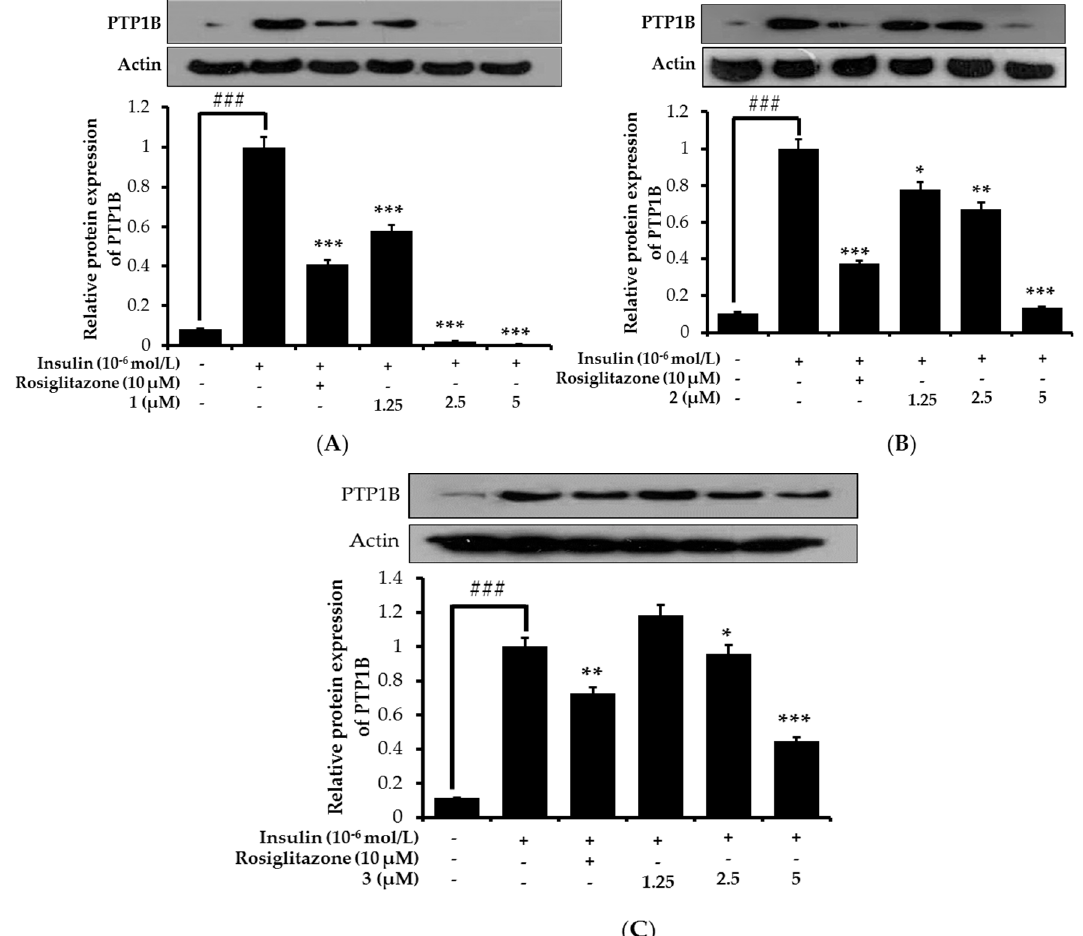
Figure 8. Effects of 1 ( A ); 2 ( B ); and 3 ( C ) on protein tyrosine phosphatase 1B (PTP1B) expression level in insulin-resistant HepG2 cells. Western blotting was performed and protein band intensities were quantified by densitometric analysis. Upper panels display representative blots. Equal protein loading was ensured and normalized against β -actin levels. Values are the mean ± standard deviation of three independent experiments; ### p < 0.001 indicates significant differences from the control group; * p < 0.05, ** p < 0.01 and *** p < 0.001 indicate significant differences from the 10 − 6 M insulin-treated control group.